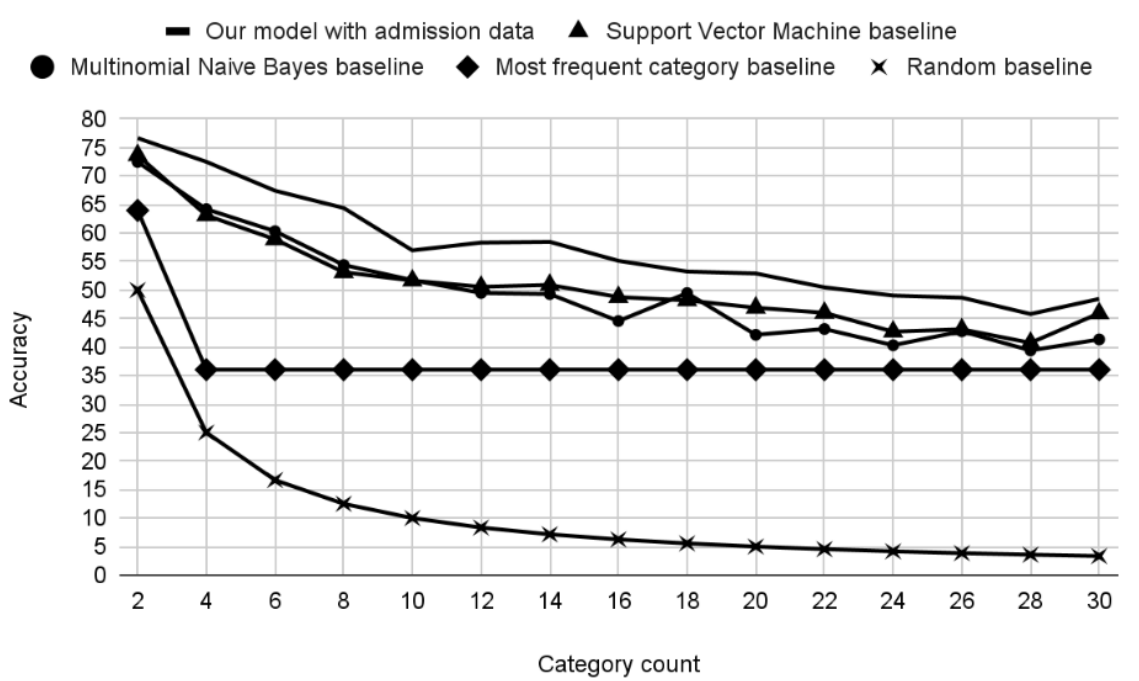
Figure 5. Chart showing the falloff of accuracy as the number of categories increases. The most fre-